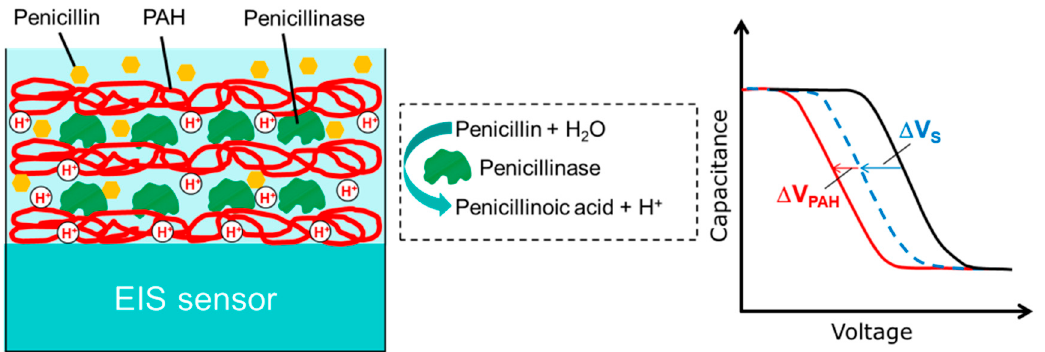
Figure 2. Functioning principle of a penicillin-sensitive EIS biosensor modified with a pH-responsive weak polyelectrolyte (PE)/enzyme multilayer: schematic structure (left), enzymatic reaction of the catalyzed hydrolysis of penicillin by the enzyme penicillinase (middle), and expected shift of the C - V curves of the EIS sensor (right). Δ V S : shift of the C – V curve due to local pH change near the gate surface induced via the enzymatic reaction and Δ V PAH : additional shift of the C – V curve induced by charge changes of weak PE macromolecules. Reproduced from Ref. [113] with permission from Springer International Publishing.